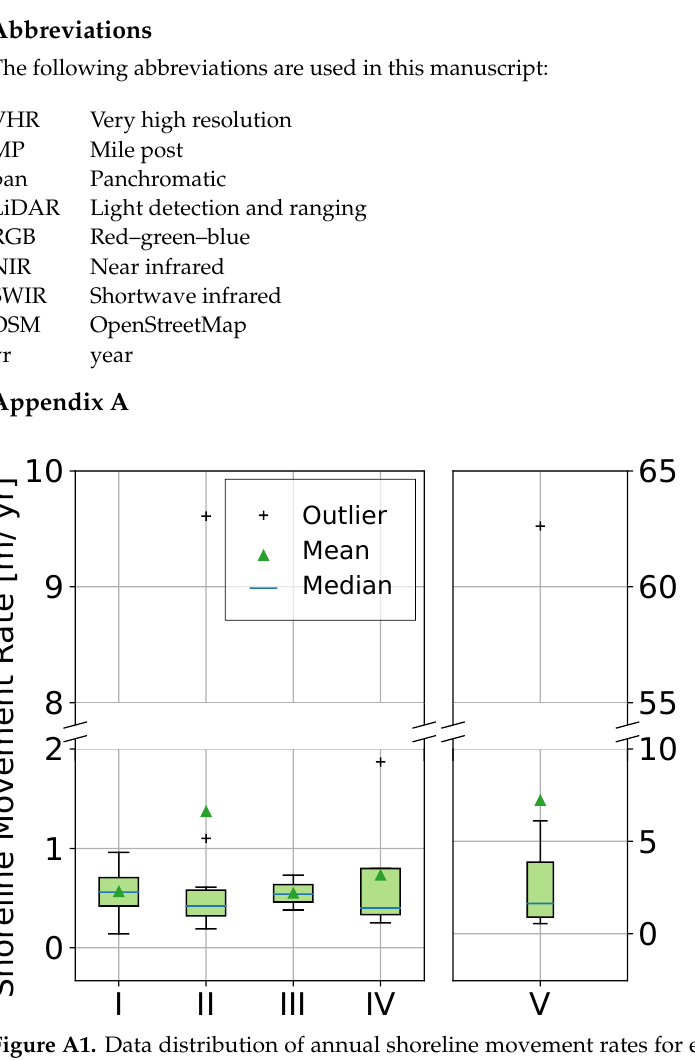
Figure A1. Data distribution of annual shoreline movement rates for each lake size category. The green-colored boxes represent the interquartile range (25th to 75th percentile), while the whiskers show the minimum (25%-percentile − 1.5 ∗ interquartile range) and maximum (75%-percentile + 1.5 ∗ interquartile range) value of the data. Please note the different (and interrupted) y-axes for lake size categories I–IV and V for a better